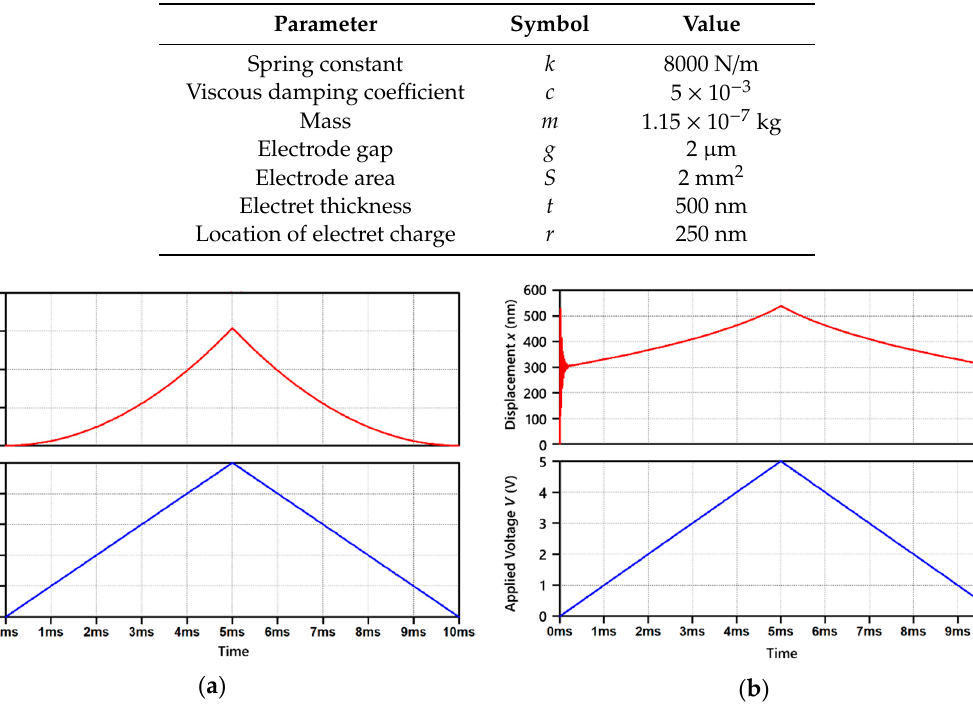
Figure 5. Simulation of static characteristics of gap-closing parallel plate electrode model with electret: ( a ) electret potential V e = 0 V; ( b ) electret potential V e = − 30 V.